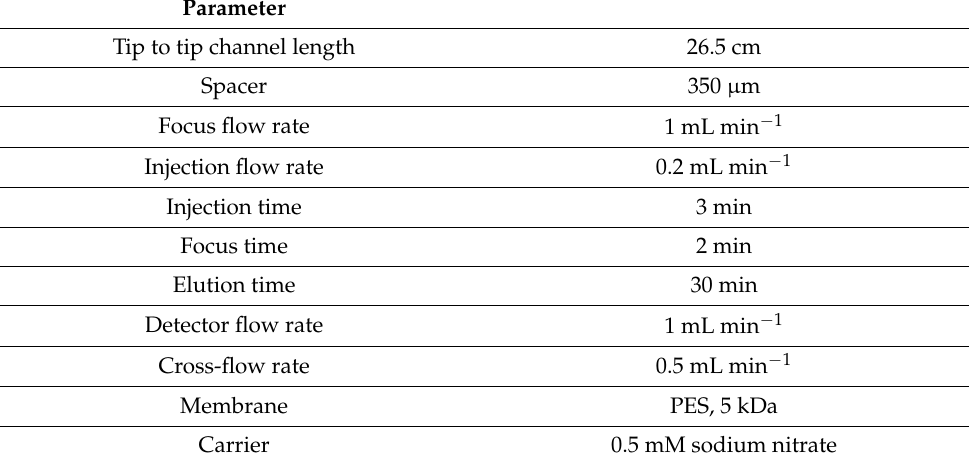
Table 3. Settings for EAF4